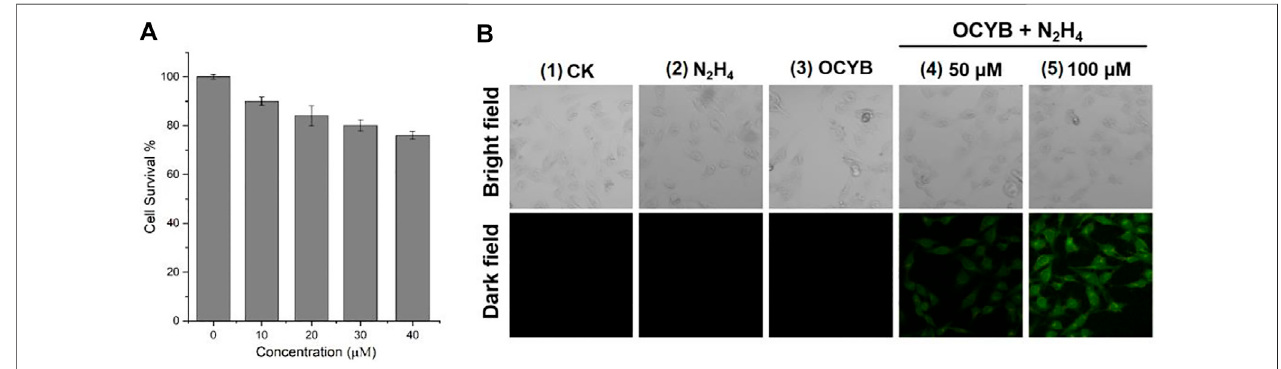
FIGURE 6 | (A) Cell survival of different concentration of OCYB; (B) Fluorescence images for HeLa cells (1: blank control. 2: N 2 H 4 . 3: OCYB. 4 and 5: HeLa cells were treated with OCYB and then incubated with N 2 H 4 , Ex = 375